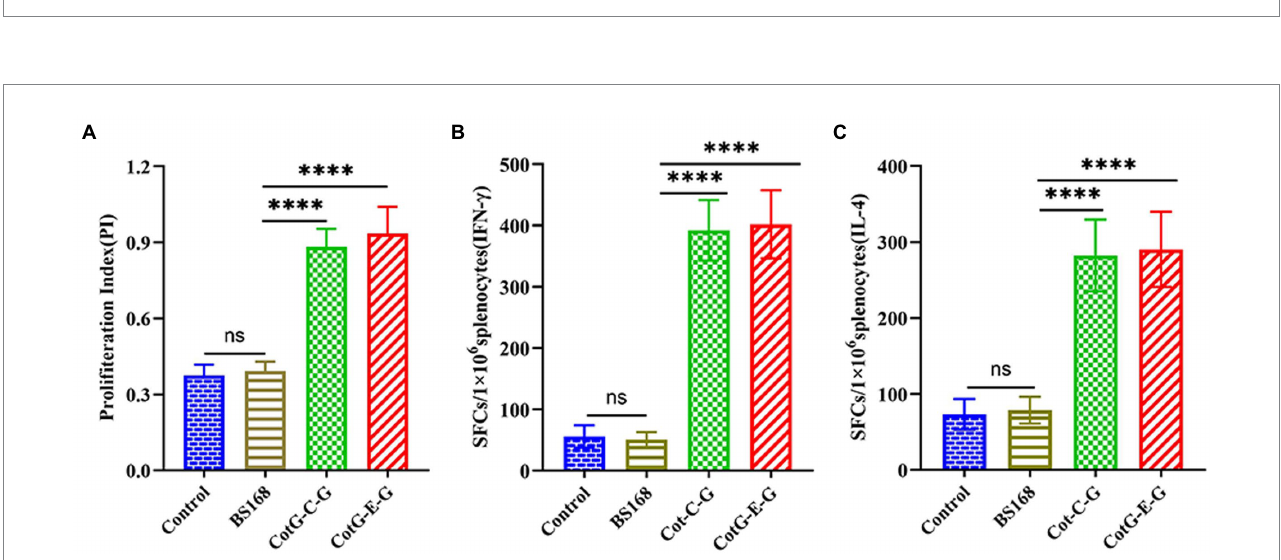
FIGURE 4 Splenocyte proliferation. On the 37th day after immunization, the spleens of mice were taken ( n = 3/group), Splenocytes were stimulated with inactivated purified HNPB3 protein. (A) CCK-8 colorimetric assay for cell proliferation index. (B,C) The levels of IFN- γ and IL-4 secreted by splenocytes were measured by ELISpot method (The ordinate represents the number of spot-forming cells per well). Data are presented as mean ± SD of each group (* p < 0.05, ** p < 0.01, *** p < 0.001, **** p <